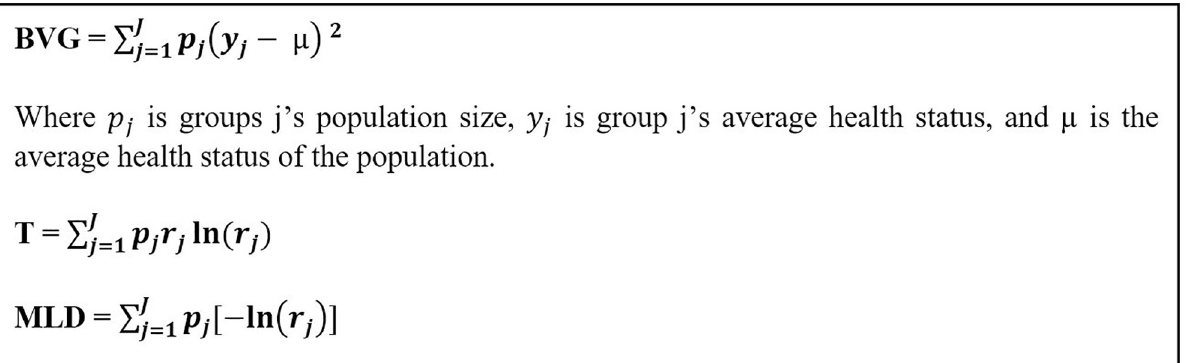
Fig 2. Absolute and relative disparities measure formulas. Average disproportionality in receipt of GCT and timely treatment is measured using three disproportionality functions: Between-Groups Variance (BGV), The Theil Index (T), and Mean Log Deviation (MLD). BGV is a useful metric of absolute disparity for unordered groups. T and MLD are entropy-based measures that quantify the relative disparity. T and MLD are complementary measures.